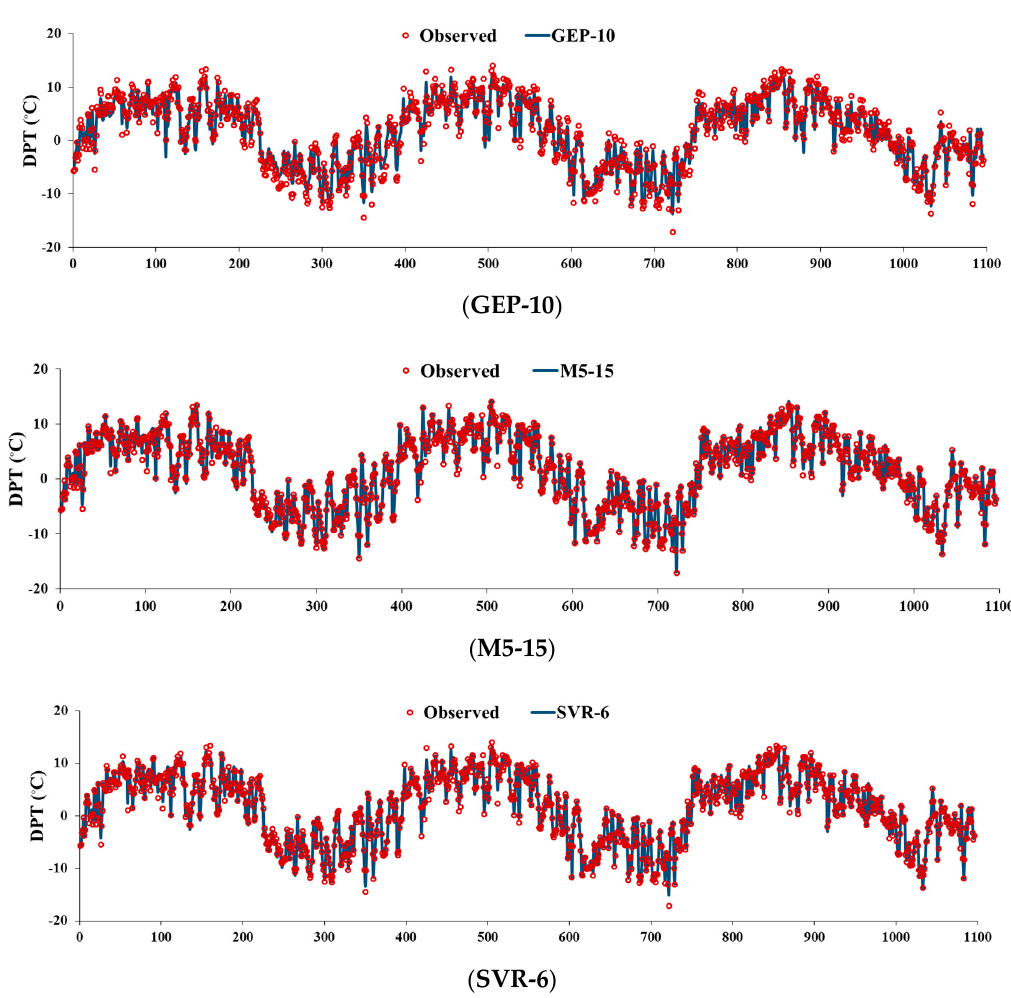
Figure 4. Observed and estimated values of dew point temperature (DPT) with the best models including ( GEP-10 ), ( M5-15 ), and ( SVR-6 ).